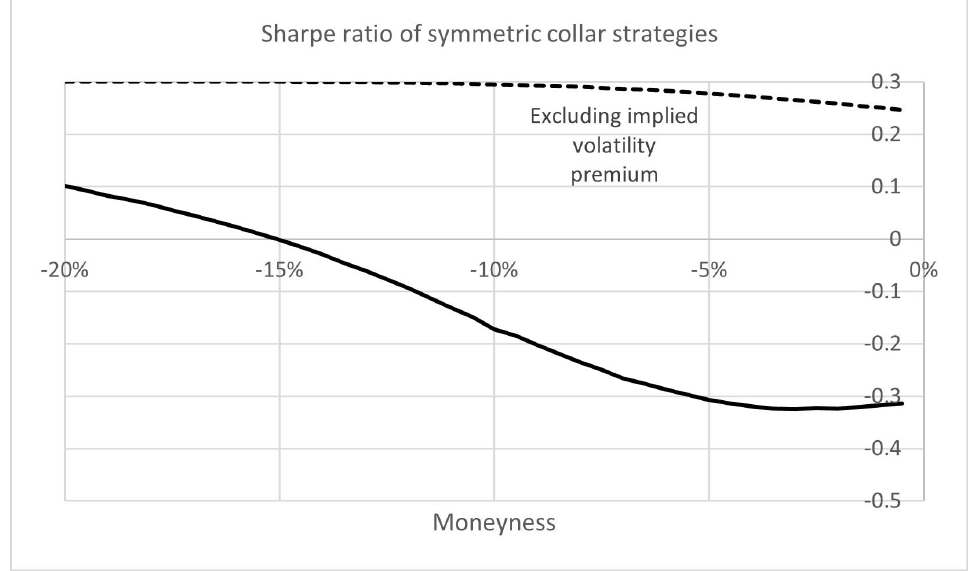
Figure 17. The Sharpe ratio for an underlying asset with an overlaid symmetric collar strategy for a range of strike prices. The dotted line assumes the implied volatility is equal to the underlying asset volatility. The solid line includes the implied volatility premium in the price of the